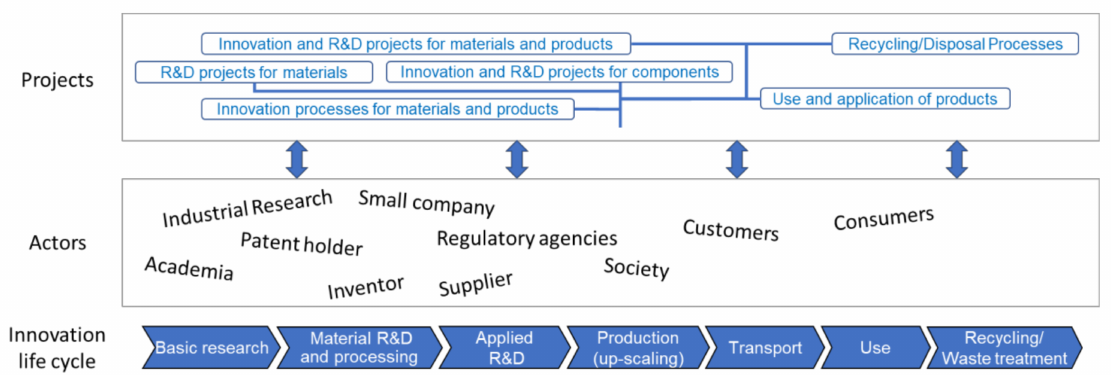
Figure 3. Organization of the innovation project